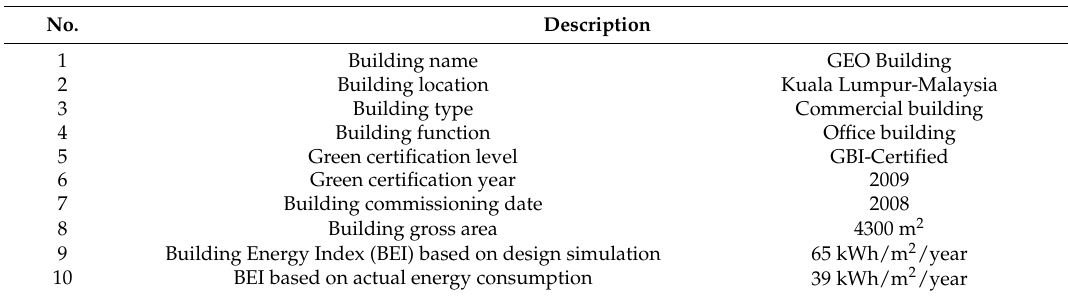
Table 1. Case Study Information.